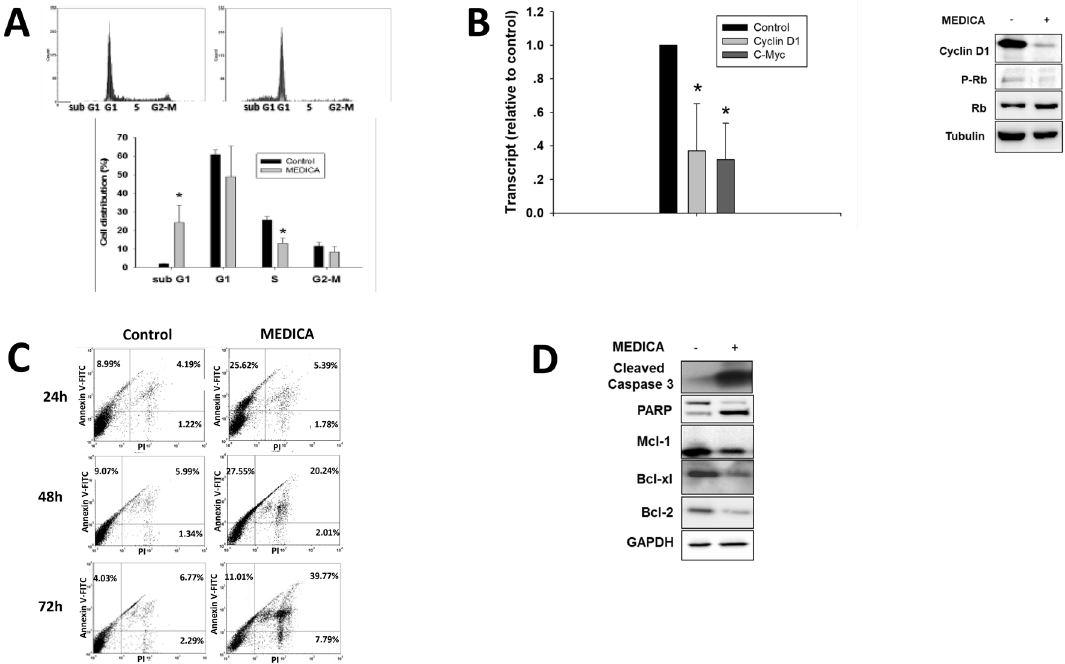
Figure 2. MM cell cycle arrest and apoptosis by MEDICA. (A) U266 MM cells were treated for 24 h with 200 μM MEDICA, stained with PI and subjected to FACS analysis. Mean ± SD of 3 independent experiments. *Significant as compared with nontreated (p < 0.05). Inset (upper frame)-representative histogram. ( B) U266 MM cells were treated for 24 h with 200 μM MEDICA. Left-CD1 and C-Myc transcripts. Mean ± SD of 3 independent experiments. *Significant as compared with nontreated (p < 0.05). Right—representative blots. ( C) U266 MM cells were treated for 24, 48 or 72 h with 200 μM MEDICA as indicated, stained with Annexin V-FITC/PI, and subjected to FACS analysis. Representative histograms. ( D) U266 MM cells were treated for 24 h with 200 μM MEDICA. Representative